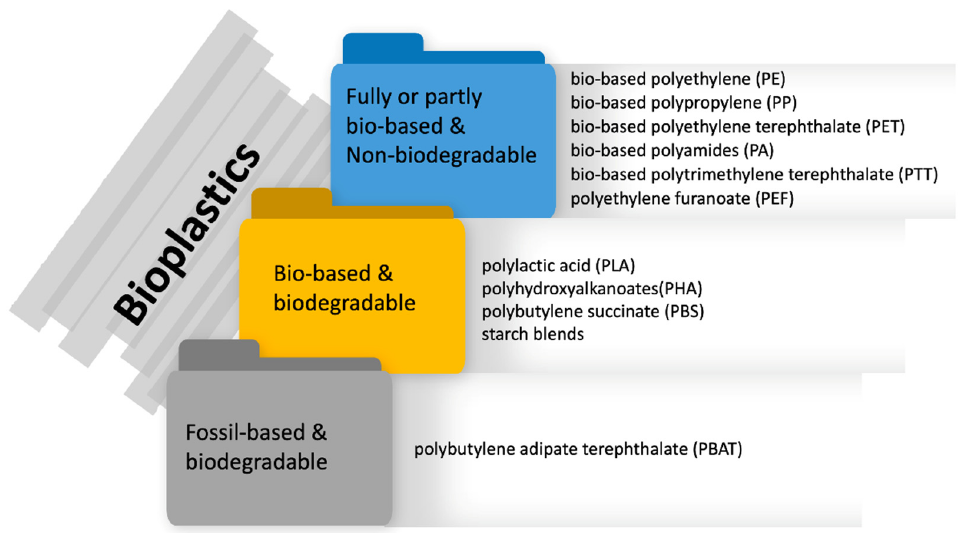
Figure 1. Different types of bioplastics (Source: [8], the illustration is created by the author).